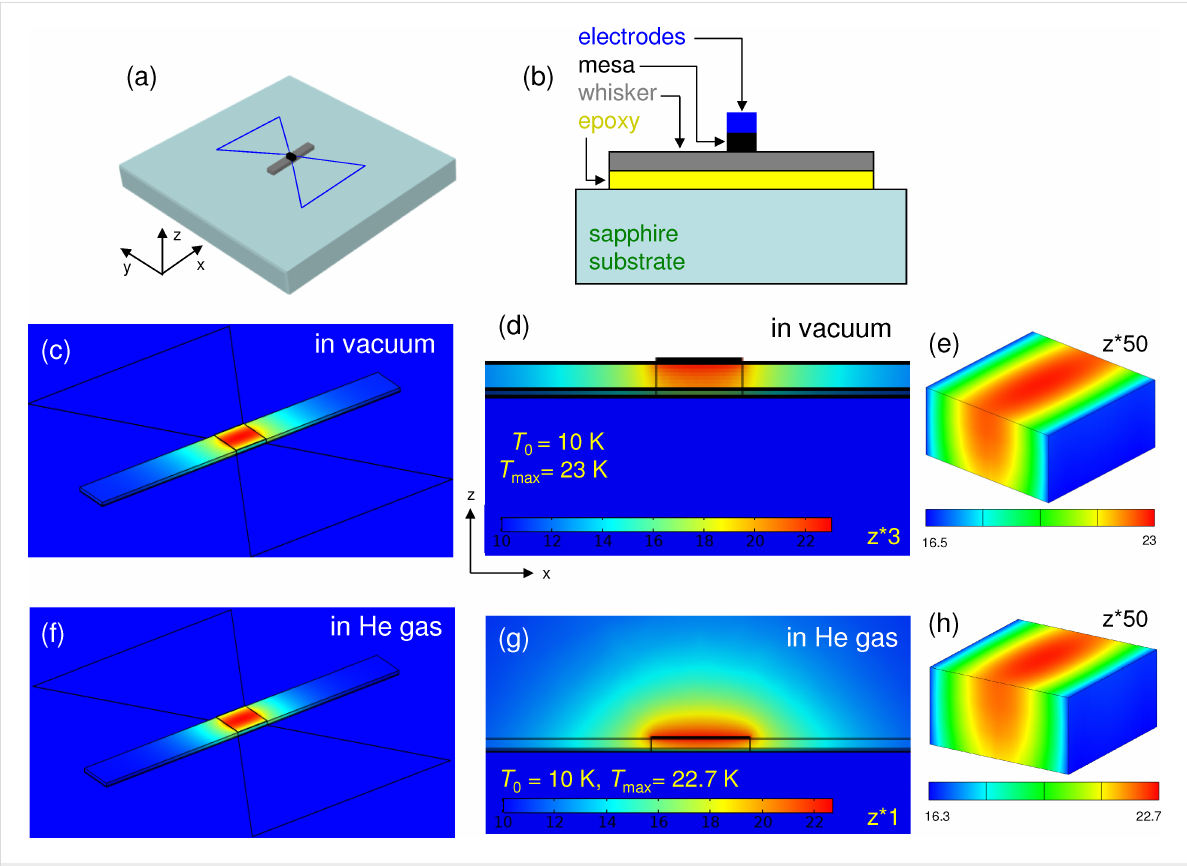
Figure 4: Heat transport in a whisker-based device with an electrode. (a) A sketch of the device and (b) a cross section through the mesa (not to scale). (c–e) Calculated temperature distribution for the device in vacuum. (f–h) The same for the device in exchange He gas.